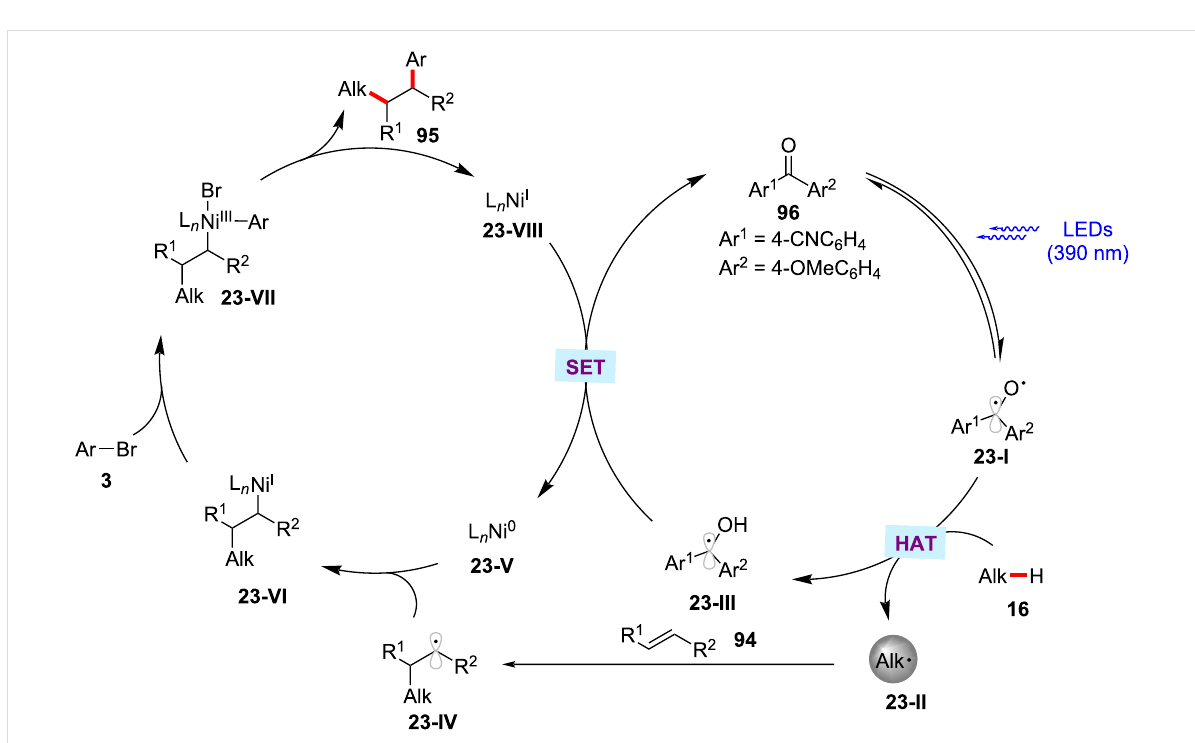
Figure 23: Proposed catalytic mechanism for the diaryl ketone HAT catalysis and nickel catalysis enabled dicarbofunctionalization of